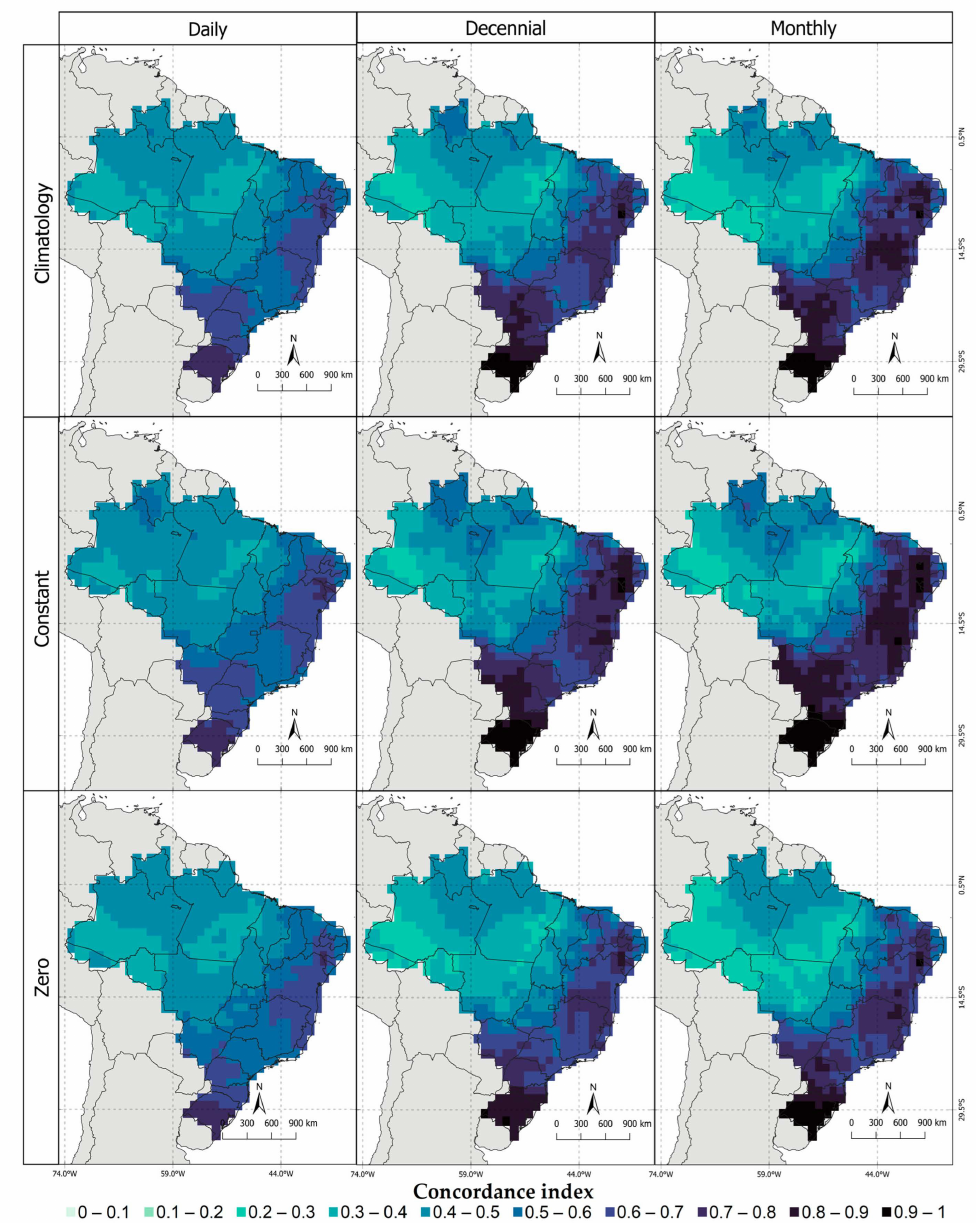
Figure 9. Solar radiation CI. The upper panel is derived from the BAM-CLIM simulations, the middle panel is derived from the BAM-CTE simulations, and the bottom panel is derived from the BAM-ZERO simulations. The left column shows CI on a daily scale, the middle column shows CI on a decennial scale, and the right column shows CI on a monthly